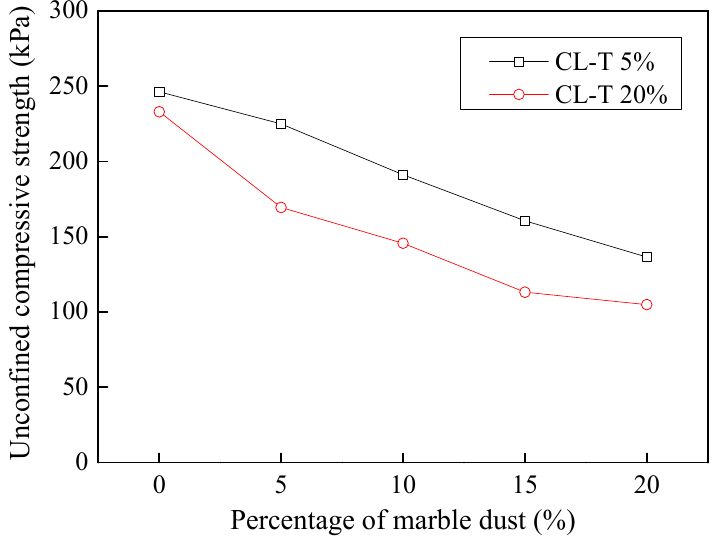
Figure 21. Improvement of tannery effluent contaminated CL soil using marble dust.